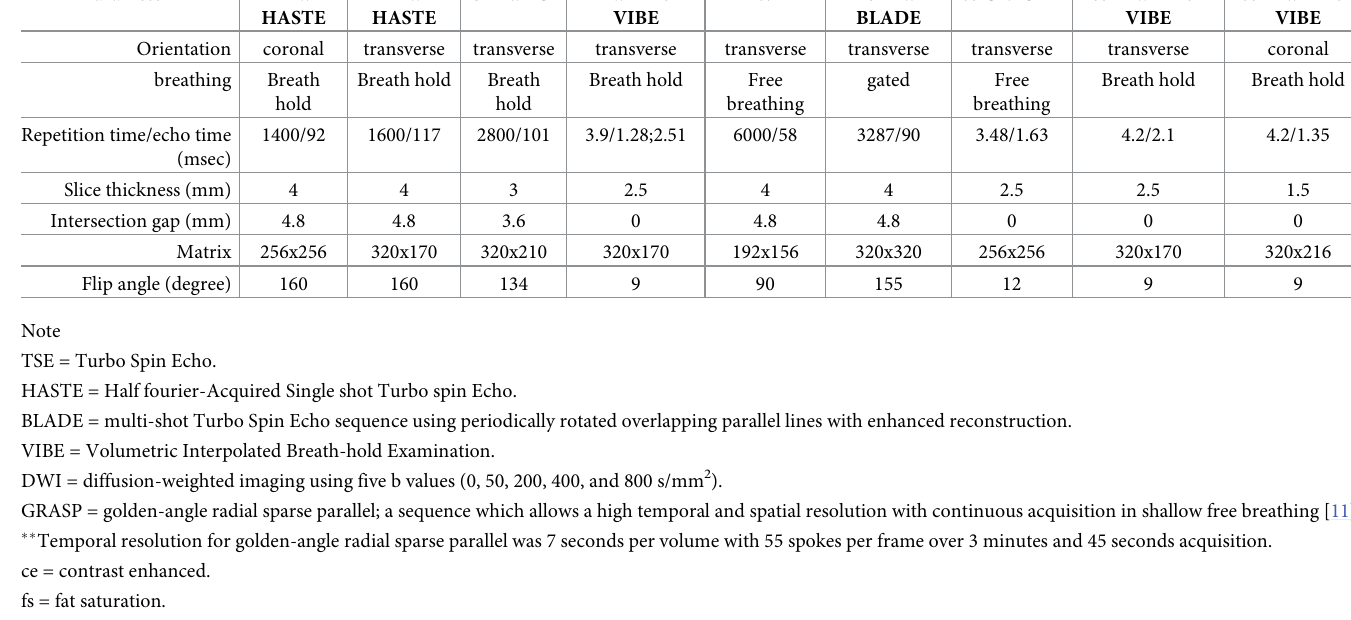
upper abdomen was acquired during 8 min, 2.5 h after the intravenous injection of 68 Ga-DOTA- exendin-4. PET images were reconstructed using an ordered-subsets expectation maximization (OSEM) algorithm with three iterations and 25 subsets. Low-dose CT (120 kVp, 30–100 mAs) was used in all patients for attenuation correction and to provide an anatomic reference.